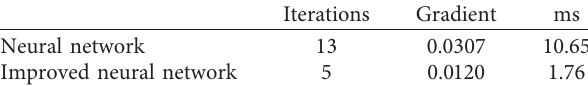
Figure 10: Error comparison. Table 1: Neural network speed